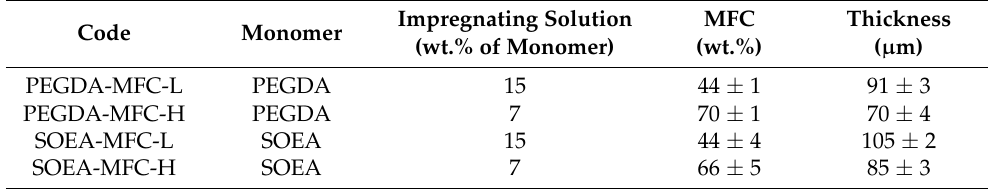
Table 1. Sample descriptions: monomer type and concentration, final MFC concentration, and film thickness.